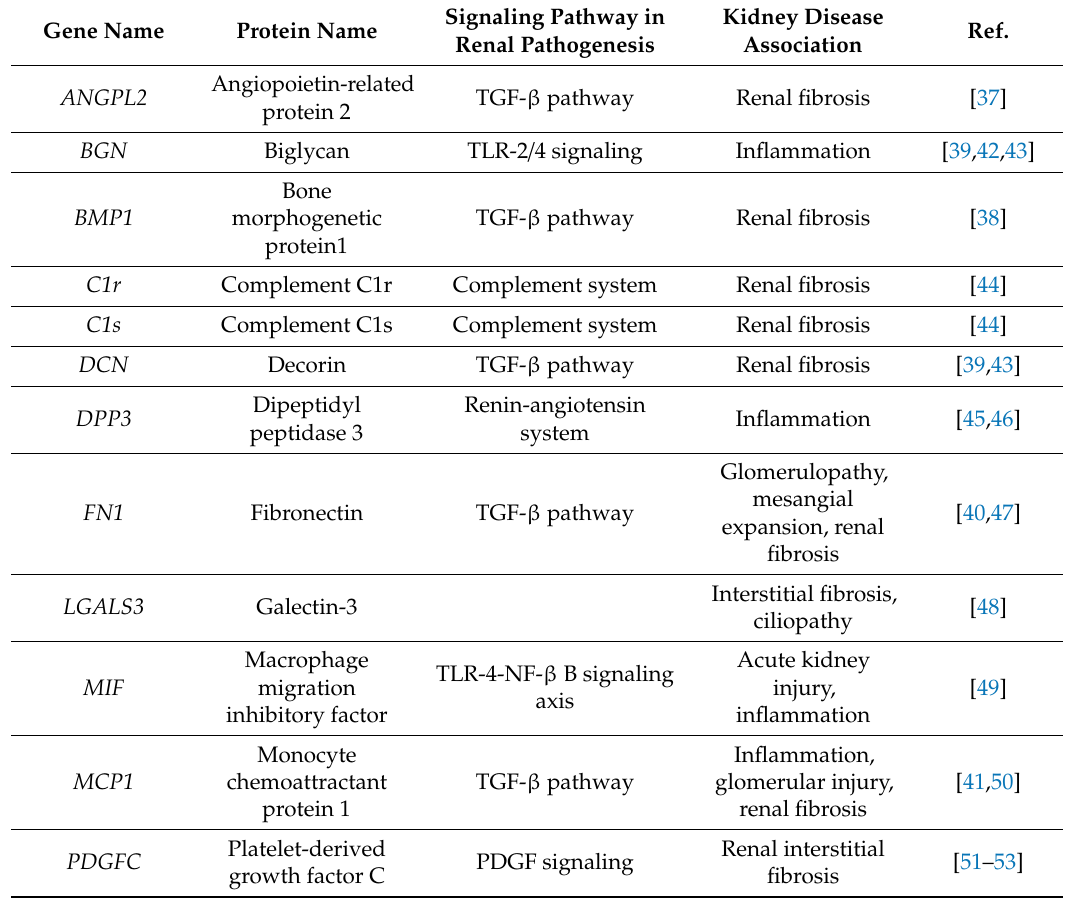
Table 1. Proteins secreted by LLC1 cells related to renal